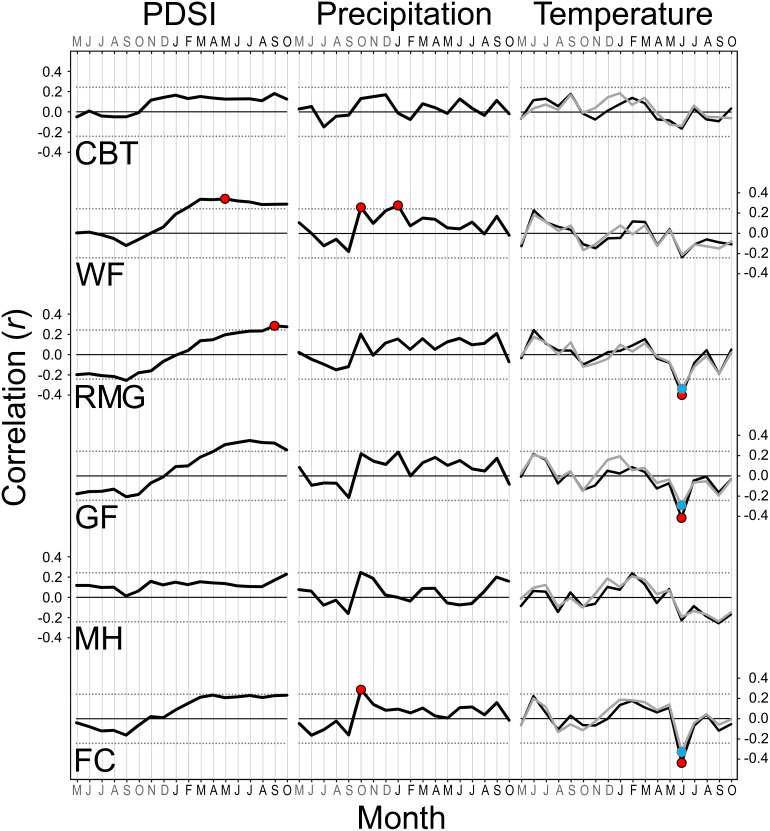
Summary of climate sensitivities for six Sequoiadendron giganteum locations.Bootstrapped correlations and response functions of residual tree-ring chronologies against monthly Palmer Drought Severity Index (PDSI), precipitation, and maximum and minimum temperature conducted over a 114-year common period (1895–2008). Thicker black lines indicate correlation values. Thin dotted lines represent cutoff for statistical significance (P<0.01). Colored circles show months with significant correlations and response functions. Grey lines and blue circles represent minimum temperature. Letters indicate 18 months from May of previous year to October of current year. Locations arranged by latitude from north (top) to south (bottom).